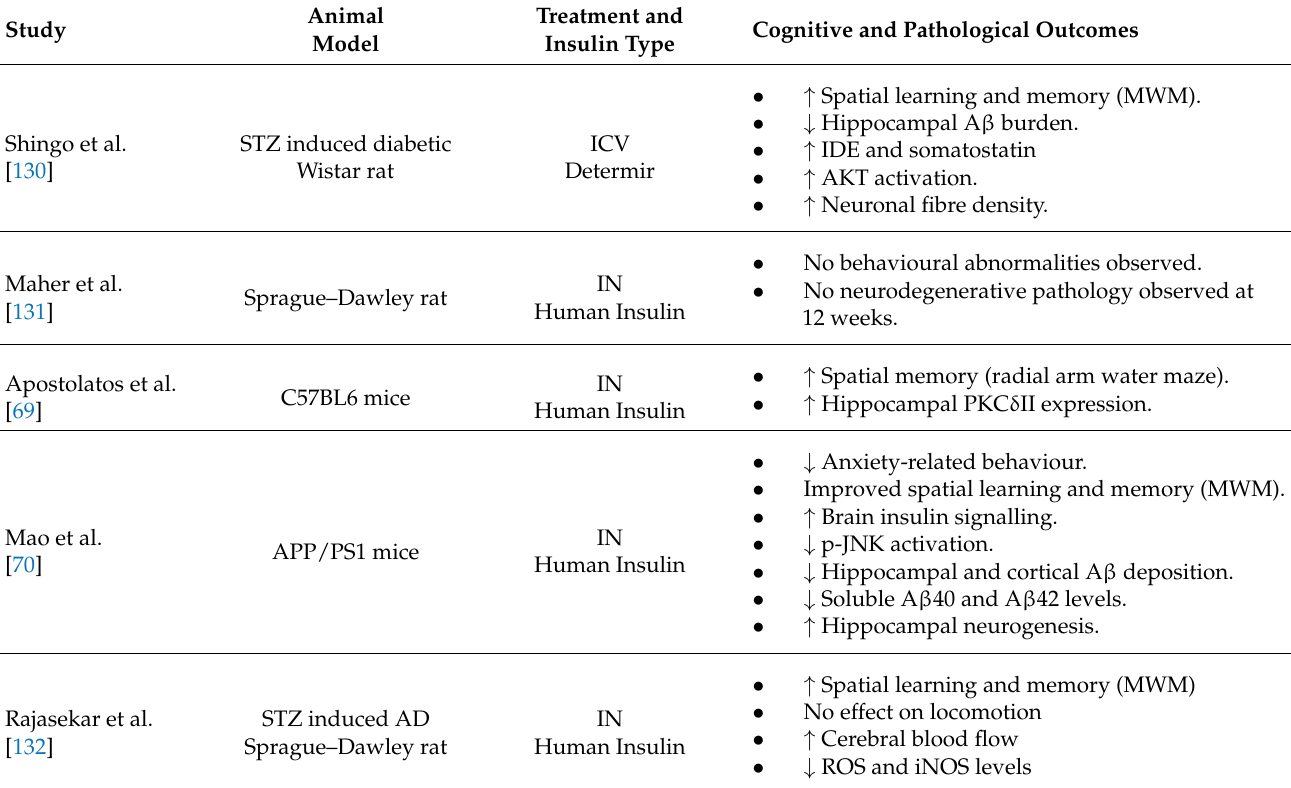
Table 1. Animal studies assessing the effectiveness of insulin treatment in the